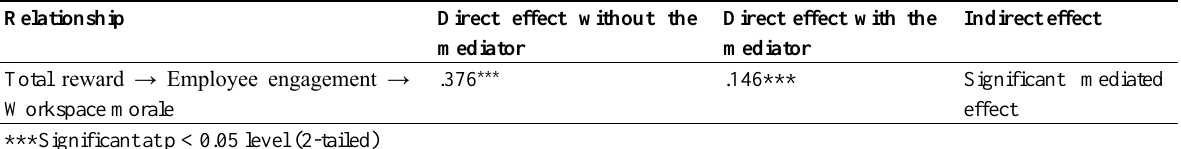
Table 4: Mediation analysis